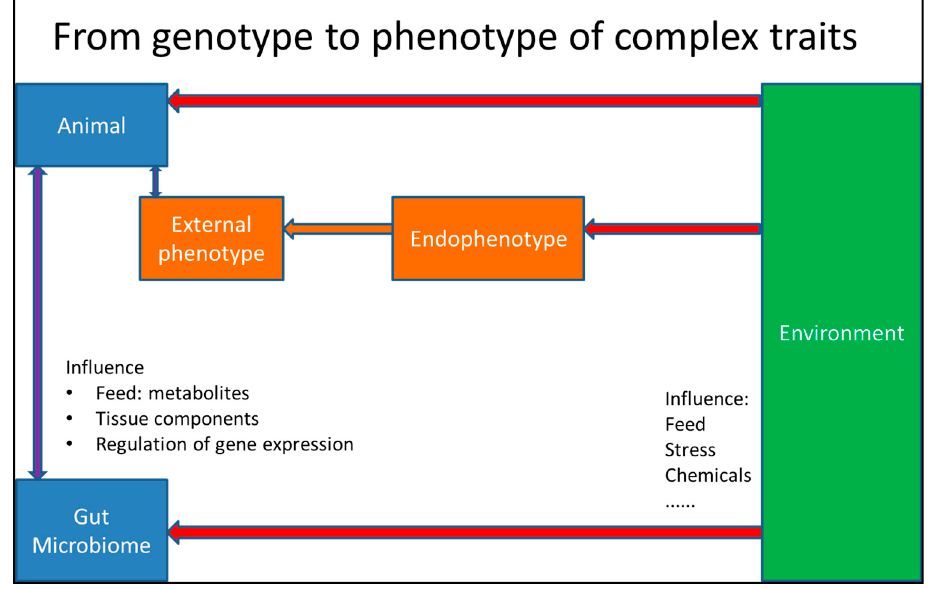
Figure 3. The interactions between the environment, the animal and the gut microbiome; and the direct interactions between the gut microbiome and the animal. The blue boxes represents the genome(s) of the animal. The orange boxes represent the phenotypes of the animal. The green box represents the environment. Red arrows indicate (in) direct effects of the environment. Purple arrows indicate two-way interactions. It should be noted that it is possible to regard the composition and diversity of the microbiome as an endophenotype (in which case, the box should be mixed blue/orange). If we consider this, an additional red arrow from the microbiome box to the endophenotype box should be added.